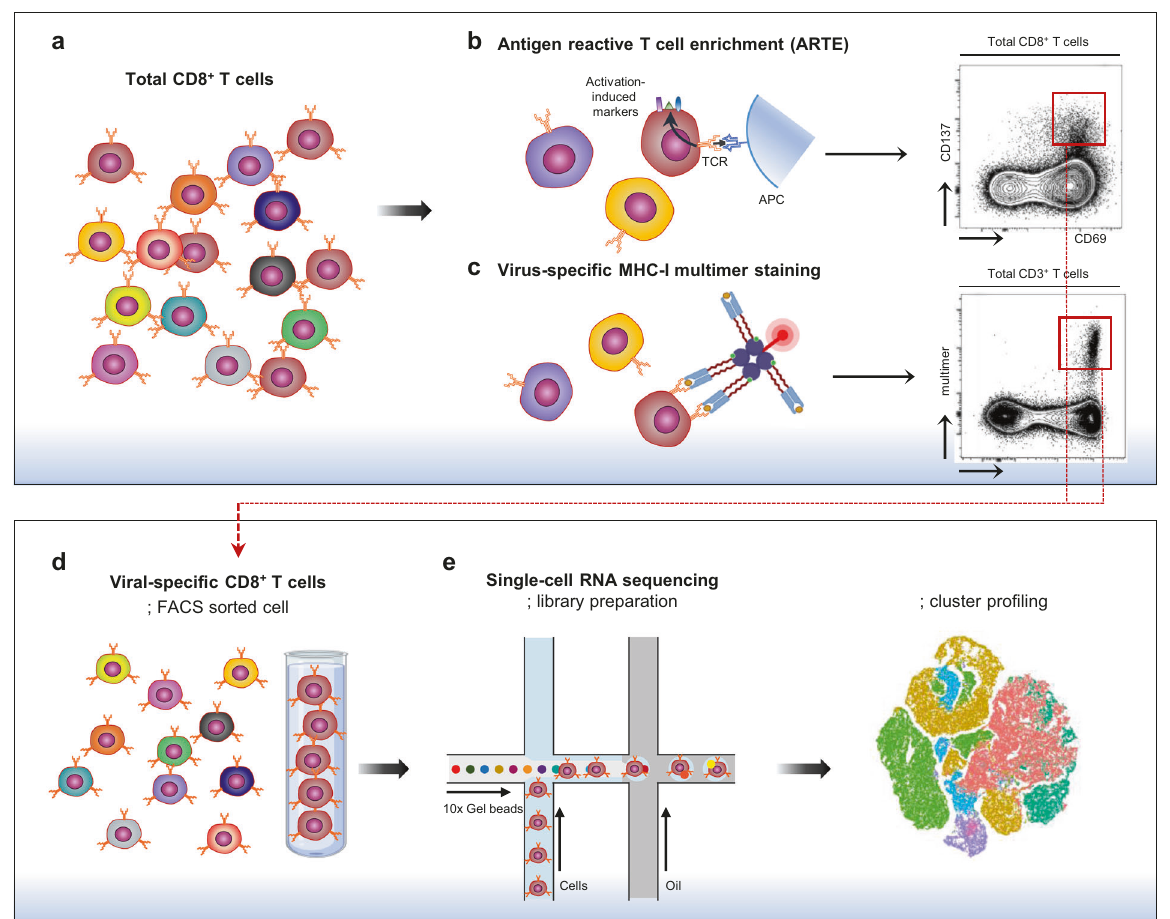
Fig. 1 Single-cell RNA sequencing of virus-speci fi c CD8 + T cells. a Total CD8 + T cells include CD8 + T cells with various antigen speci fi city. b , c Virus-speci fi c CD8 + T cells are fl uorescently detected by activation-induced markers, such as CD69 and CD137, following ex vivo stimulation with viral antigens ( b ) or MHC-I multimer staining ( c ). d Virus-speci fi c CD8 + T cells are enriched by sorting fl uorescently stained cells. The procedure enriching activation-induced marker + cells is called antigen-reactive T-cell enrichment (ARTE). e Enriched virus-speci fi c CD8 + T cells are analyzed by single-cell RNA sequencing, and single-cell heterogeneity is